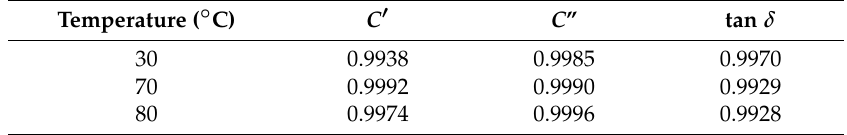
Figure 7. The reconstructed FDS from the parametrized model and the measured FDS: ( a ) complex capacitance; ( b ) tan δ . Table 1. Goodness of fit of the FDS tested under the three temperatures: 30 ◦ C, 70 ◦ C, and 80 ◦ C